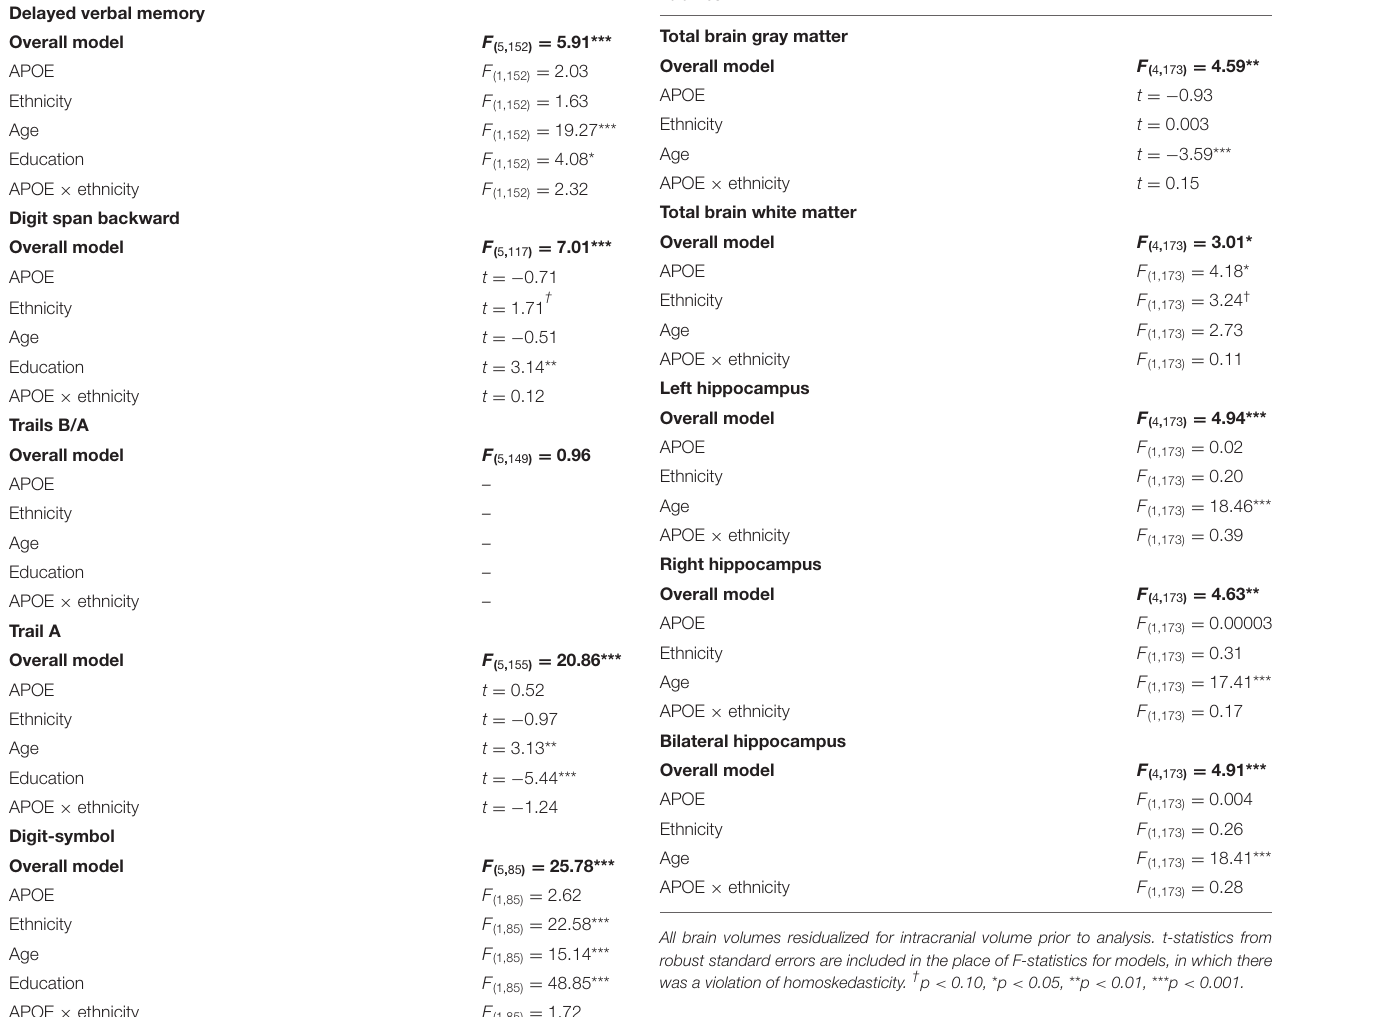
TABLE 3 | F -statistics for overall models (in bold) and exposure/covariate factors for models predicting total gray matter, total white matter, and hippocampal brain